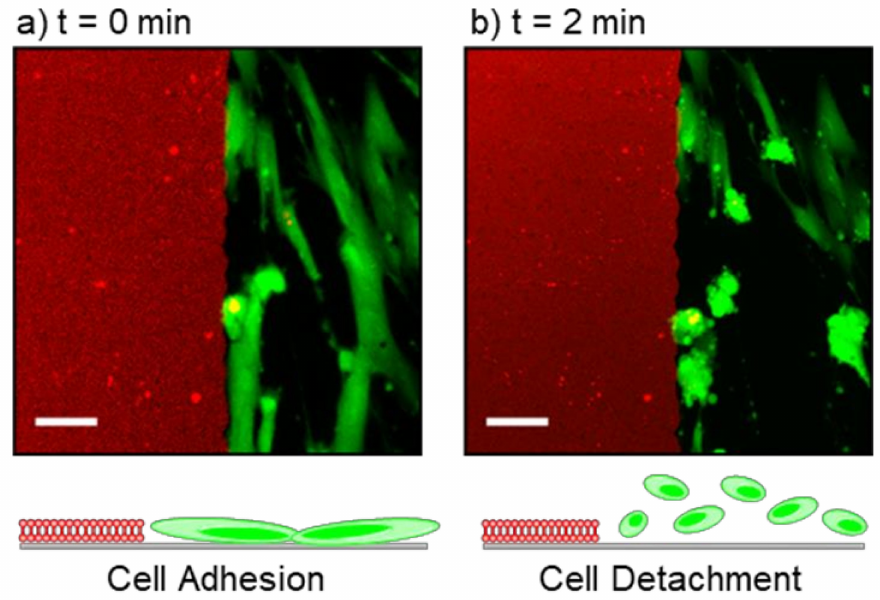
Figure 6. ( a ) Confocal images of adhered cells (green) alongside a printed tethered phospholipid bilayer (red) (t = 0 min). ( b ) Upon exposure to a confocal laser, cells gradually detached from the surface (t = 2 min). This effect was observed only in the presence of tethered phospholipid bilayers. Image scale bars: 50 µ